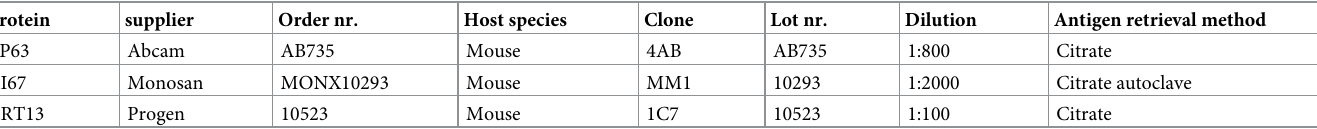
Table 1. Protein supplier Order